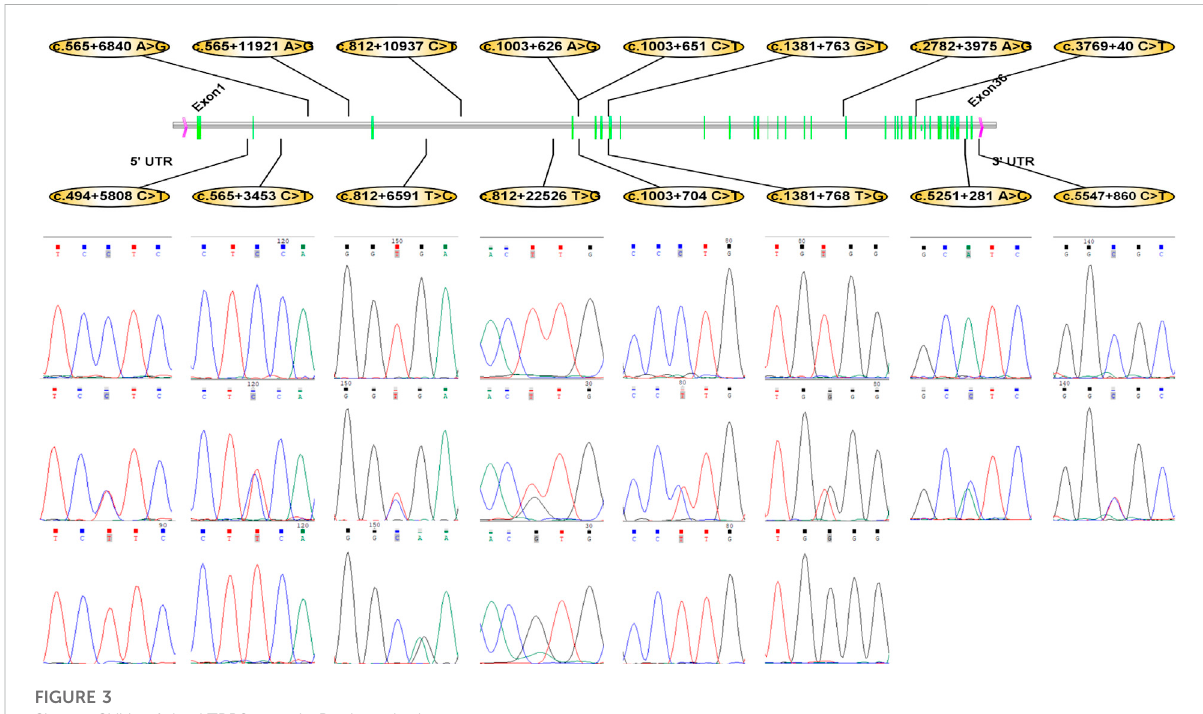
FIGURE 3 Sixteen SNVs of the LTBP2 gene in Dezhou